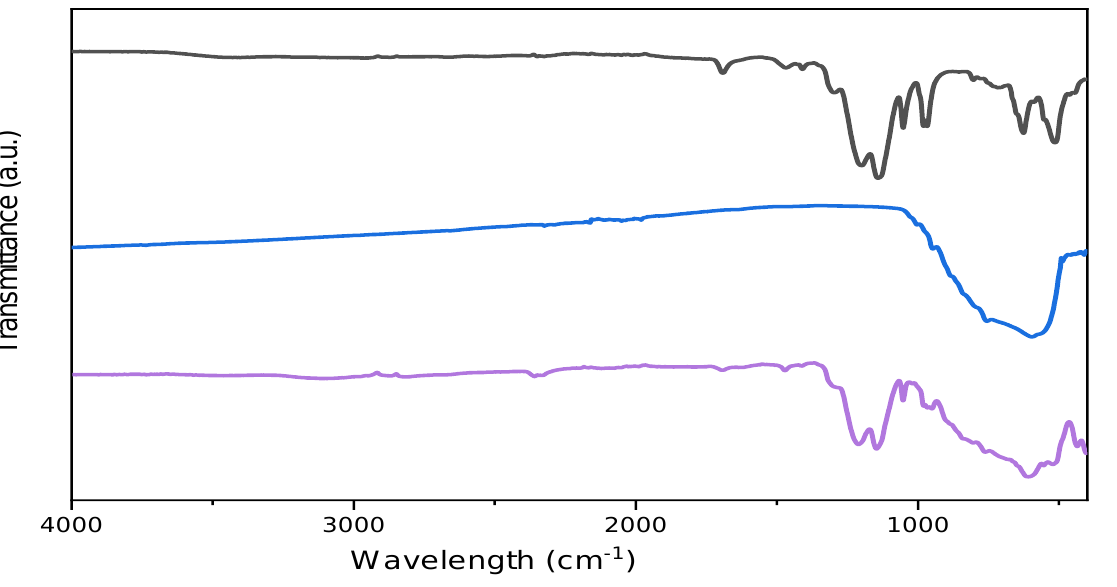
Figure 7. FTIR spectra of recast Nafion (black), tungsten oxide nanofiller calcinated at 700 °C (blue), and 15 wt.% WO 3 – Nafion hybrid membrane